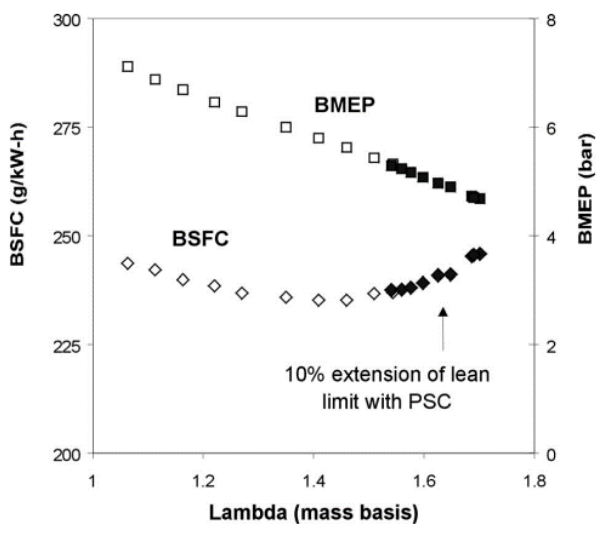
Figure 12. Extension of lean limit by partially stratified charge at 2000 rpm [204].